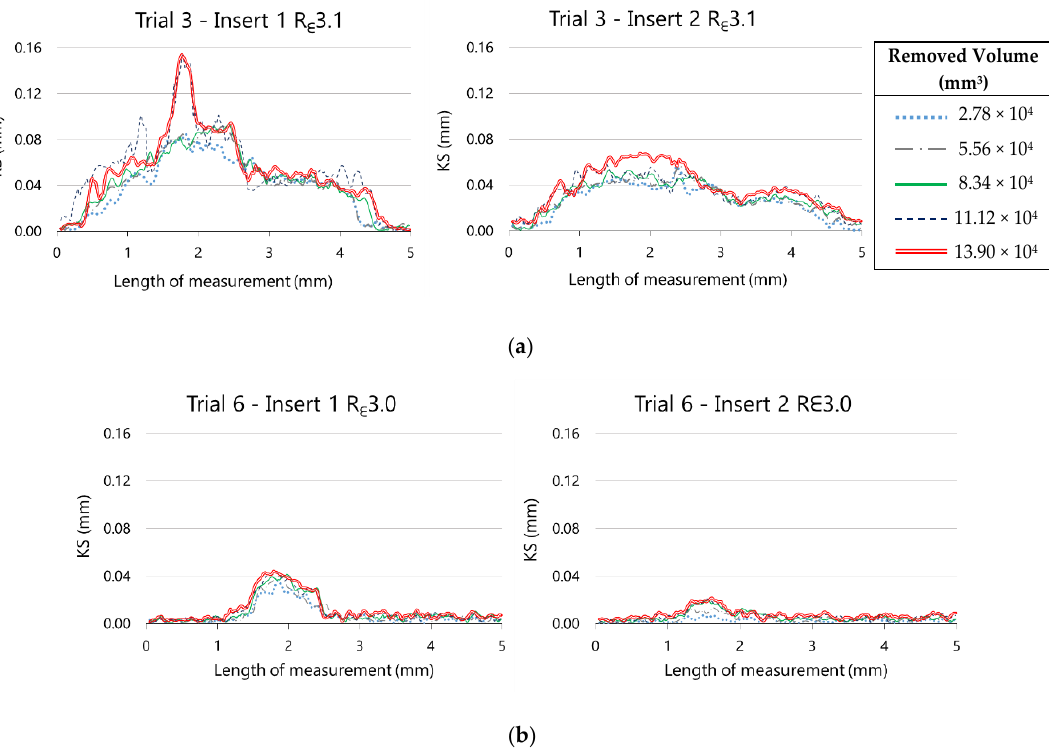
Figure 20. Evolution of the retraction of the cutting edge along the nose edge on ( a ) R ᗴ 3.1 inserts and ( b ) R ᗴ 3.0 inserts.